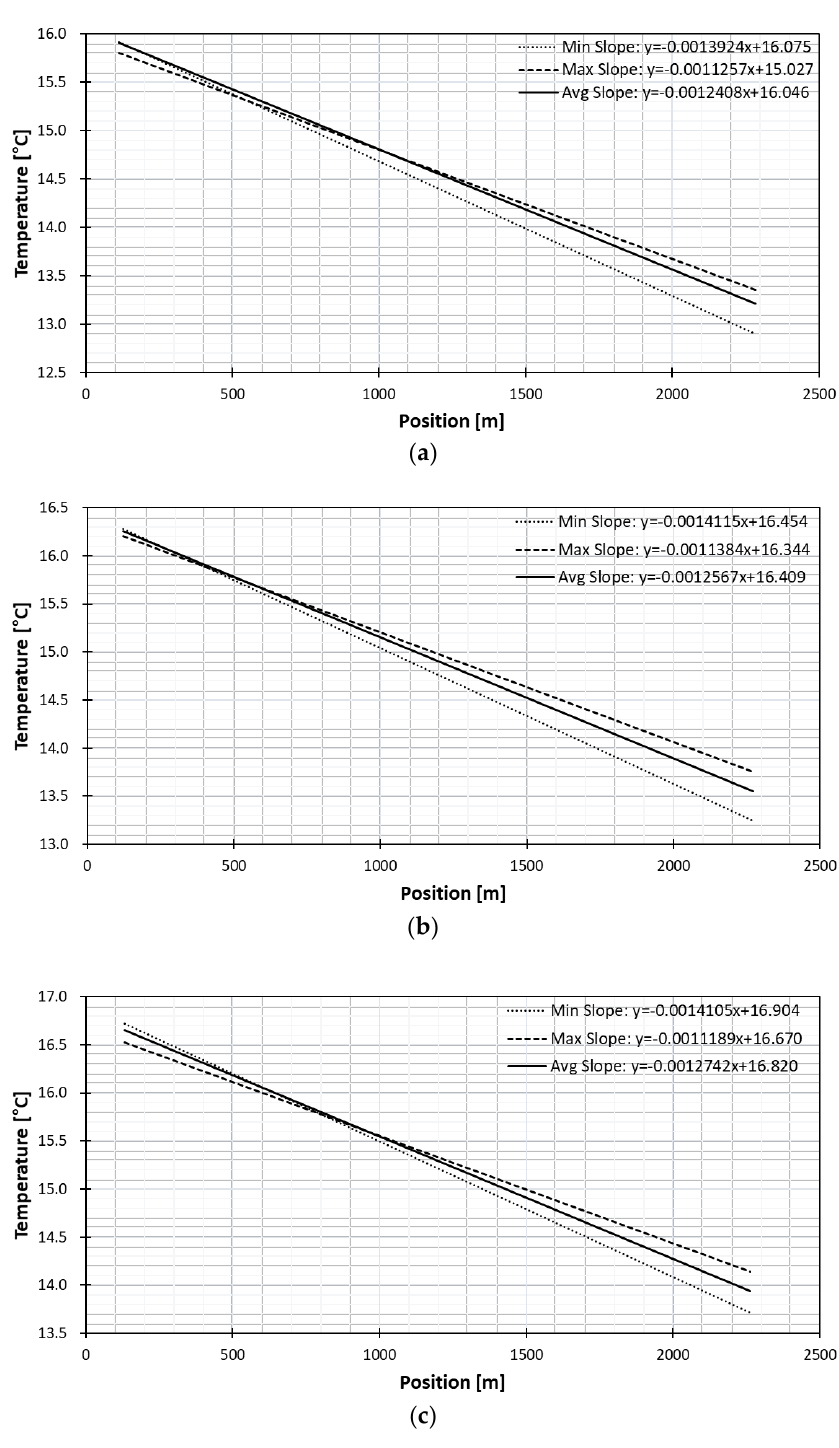
Figure 11. Slope curves of pointwise calibration method by in-well diver at ( a ) 10 m, ( b ) 20 m, ( c ) 30 m.